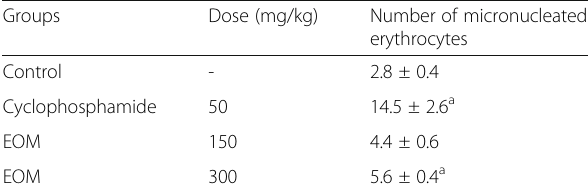
Table 3 Number of micronucleated erythrocytes in peripheral blood of mice treated with single doses of EOM and